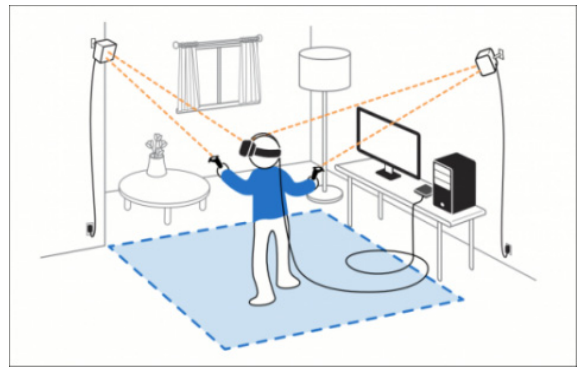
Fig. 8. The setup of the Virtual Reality System HTC Vive